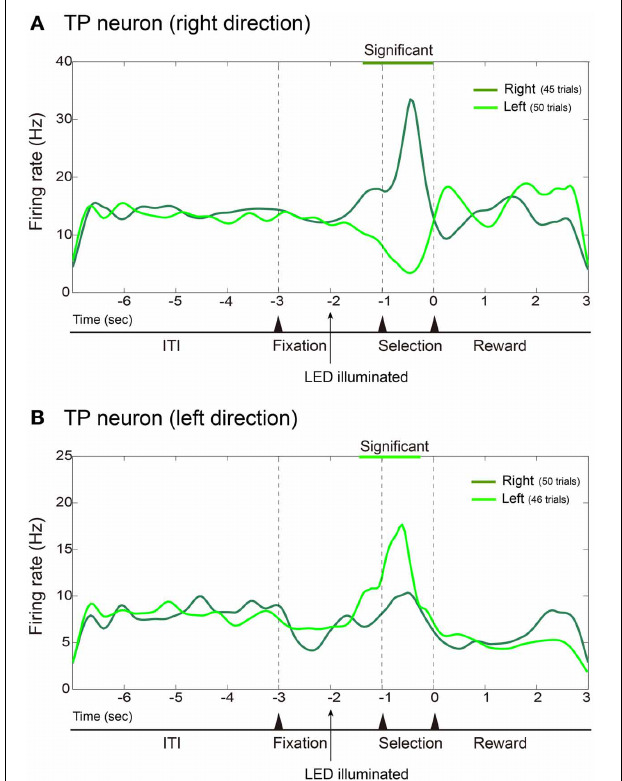
FIGURE 4 | Examples of hippocampal TP neurons. Same format as Figure 3 except that firing rates are cumulated and smoothed separately when the rats poked their nose into the left or right hole. (A) Example of TP neuron that fired more frequently during the selection period prior to nose-pokes to the right hole. (B) Example of TP neuron that fired more frequently prior to nose-pokes to the left hole.